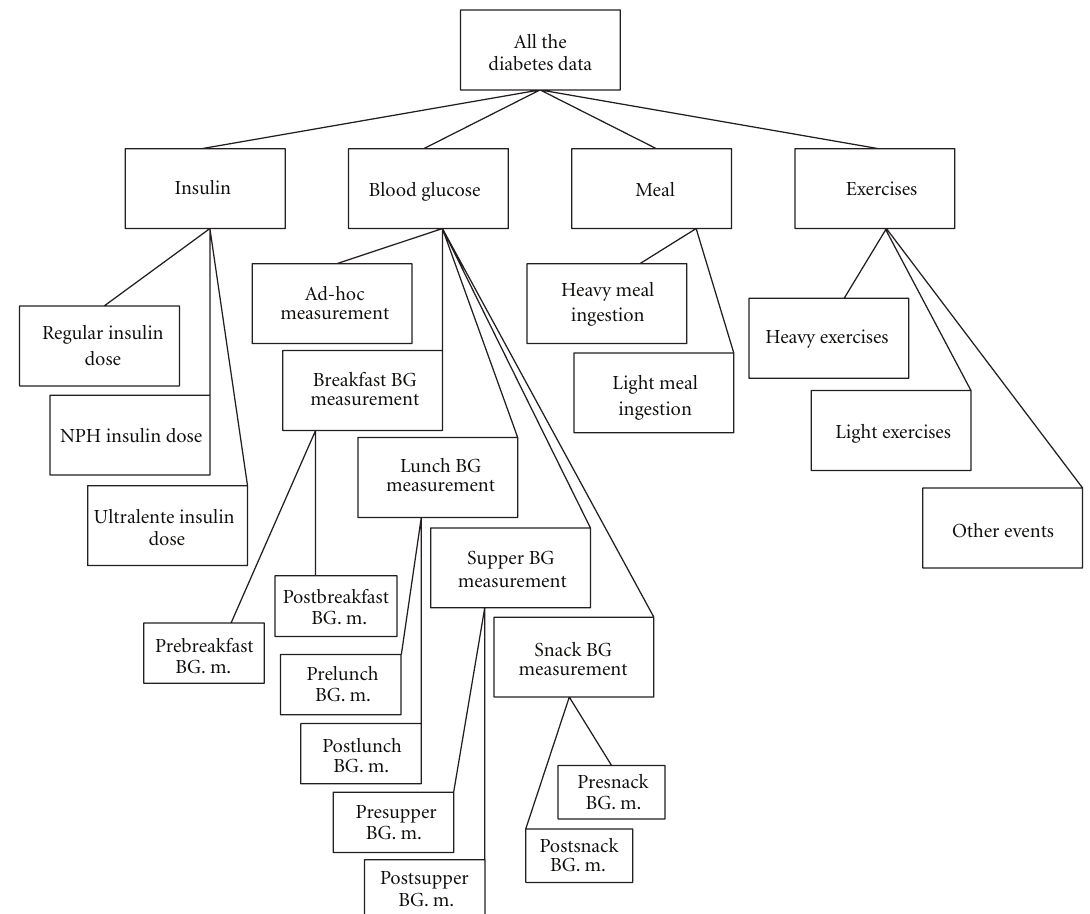
Figure 6: Concept hierarchy tree as AVT in the diabetics dataset.